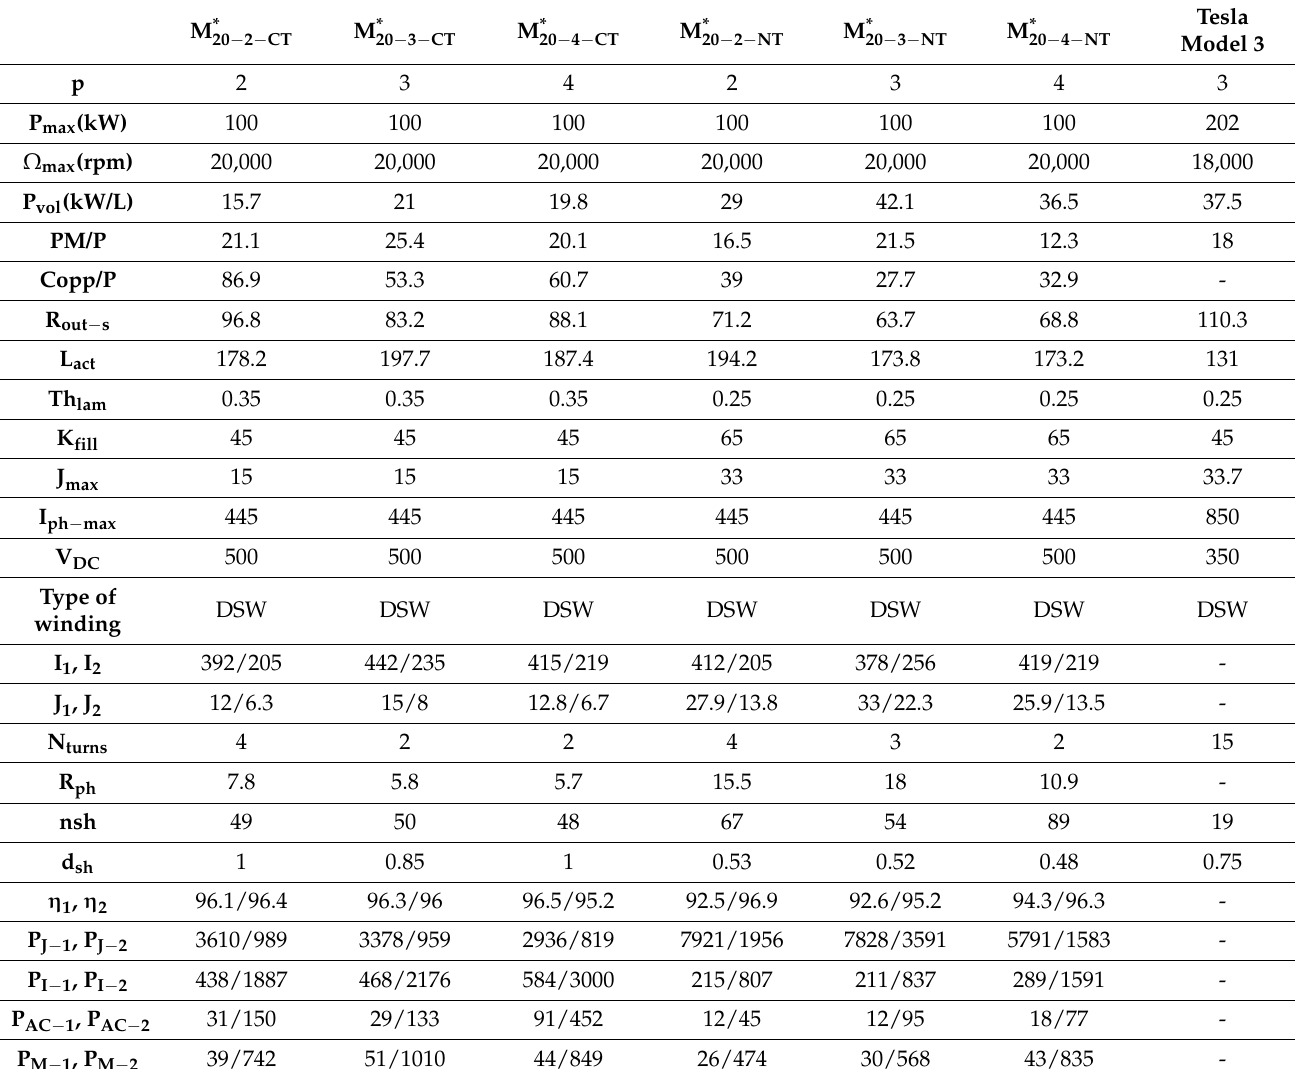
Table 6. Performances and characteristics of optimal machines operating at Ω max = 20,000 rpm and machine used in Tesla Model